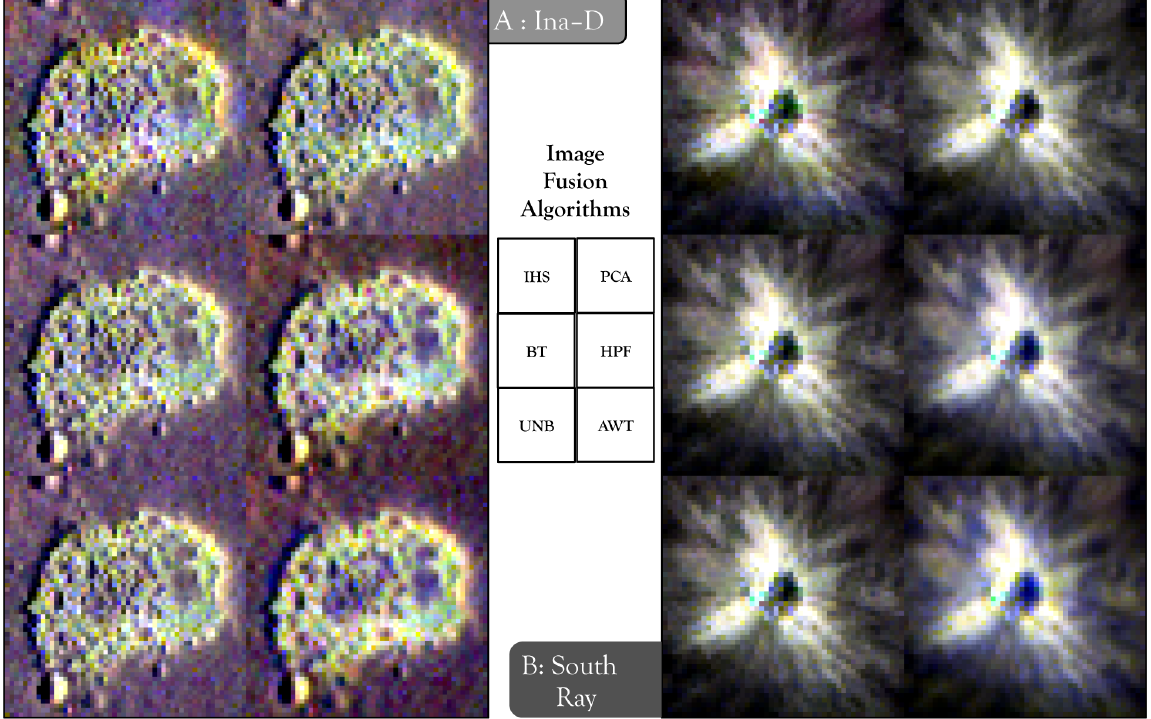
Figure 7: Image fusion results’ composite images for LROC WAC Vis 5, Vis 1, & UV 1 bands (red, green, & blue, respectively). Contrast stretch limits saturate upper and lower 2% of pixel values of individual composite